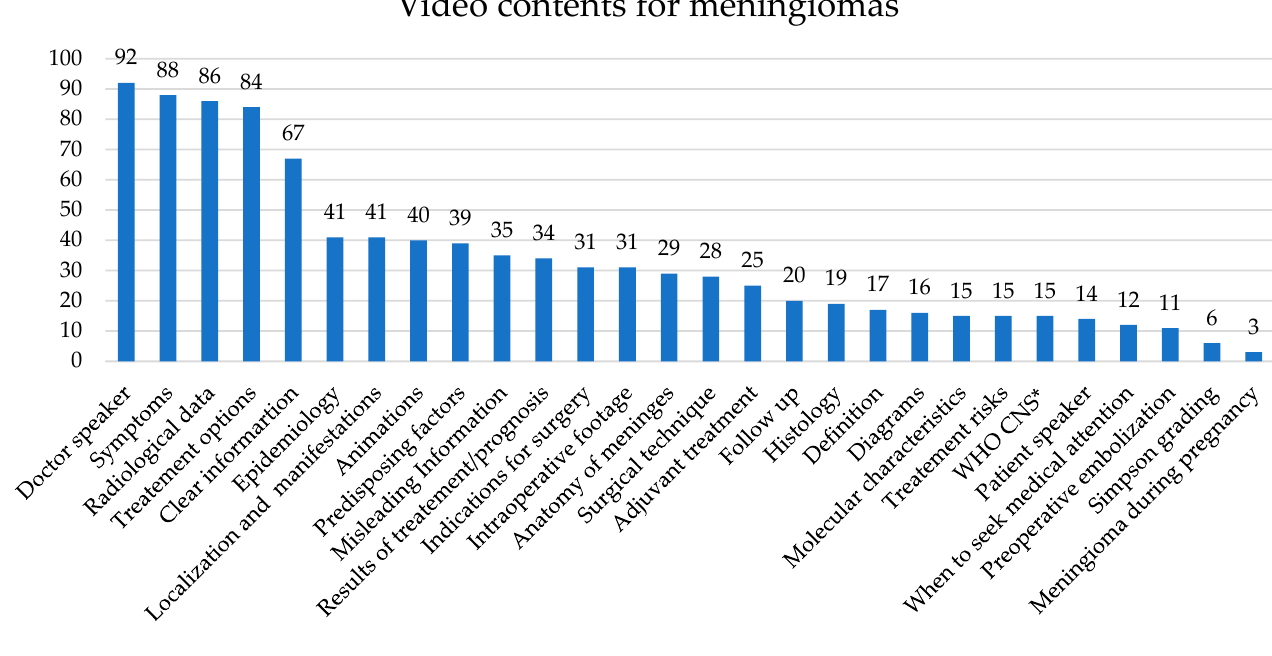
Figure 5. Video content for meningiomas. * WHO CNS—WHO classification of tumors of the central nervous system.